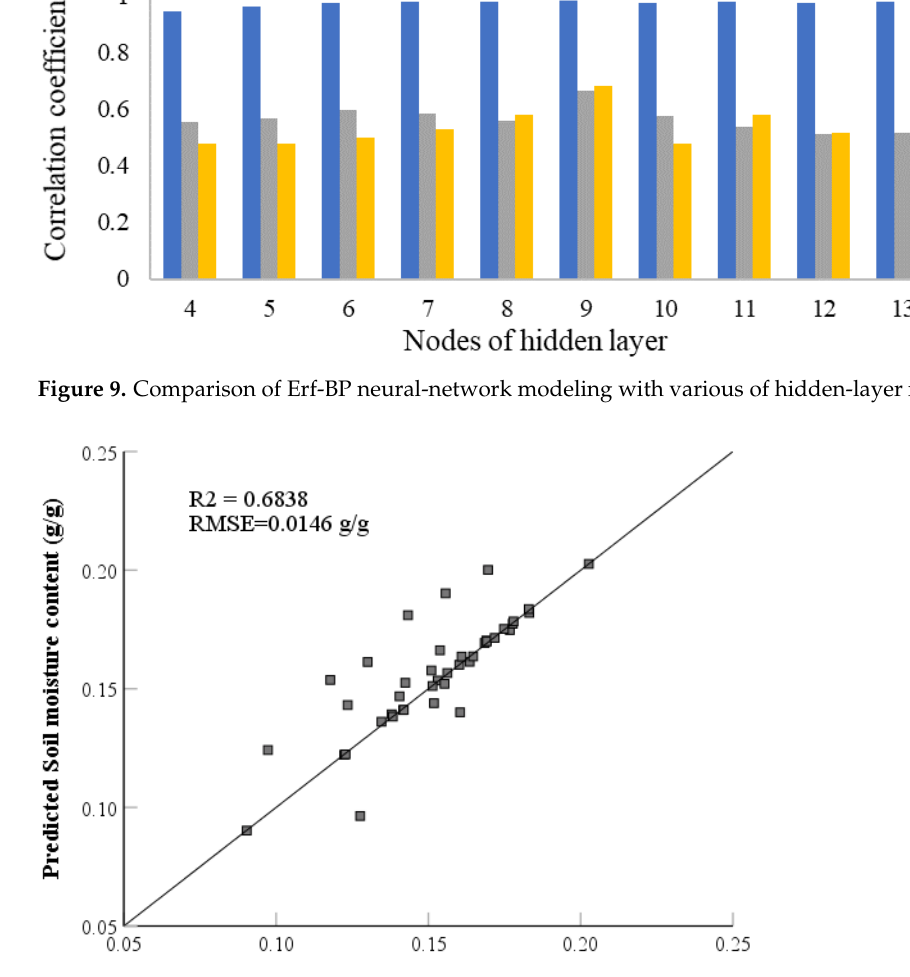
Figure 10. Scattering plot between SMC g measured and estimated by using Erf-BP artificial neural network with 9 hidden layer nodes.